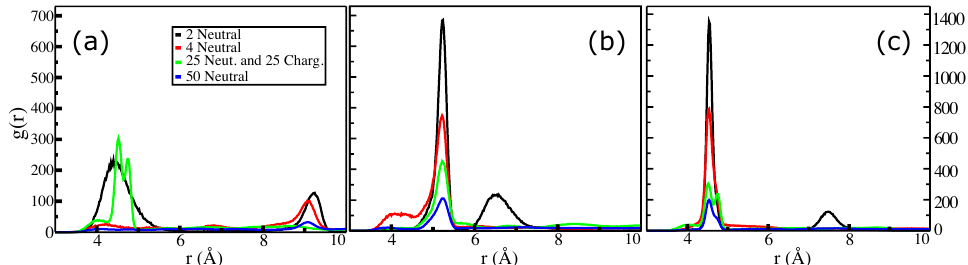
Figure 4. Size dependence of the radial distribution function (RDF). The planes of eumelanin are shown in Figure 1a. RDFs between the COMs of ( a ) the ICAQ and PTCA moieties, ( b ) the DHICA and PTCA moieties, and ( c ) the ICAQ and DHICA moieties. The systems are two uncharged, four uncharged, 25 uncharged and 25 charged, and fifty uncharged eumelanins; see details in Table 1.